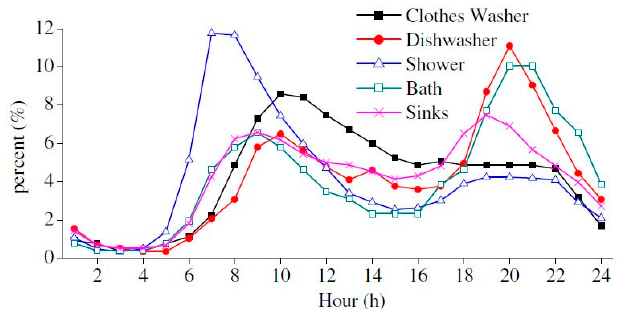
Figure 4. Water usage profile over a day [15].